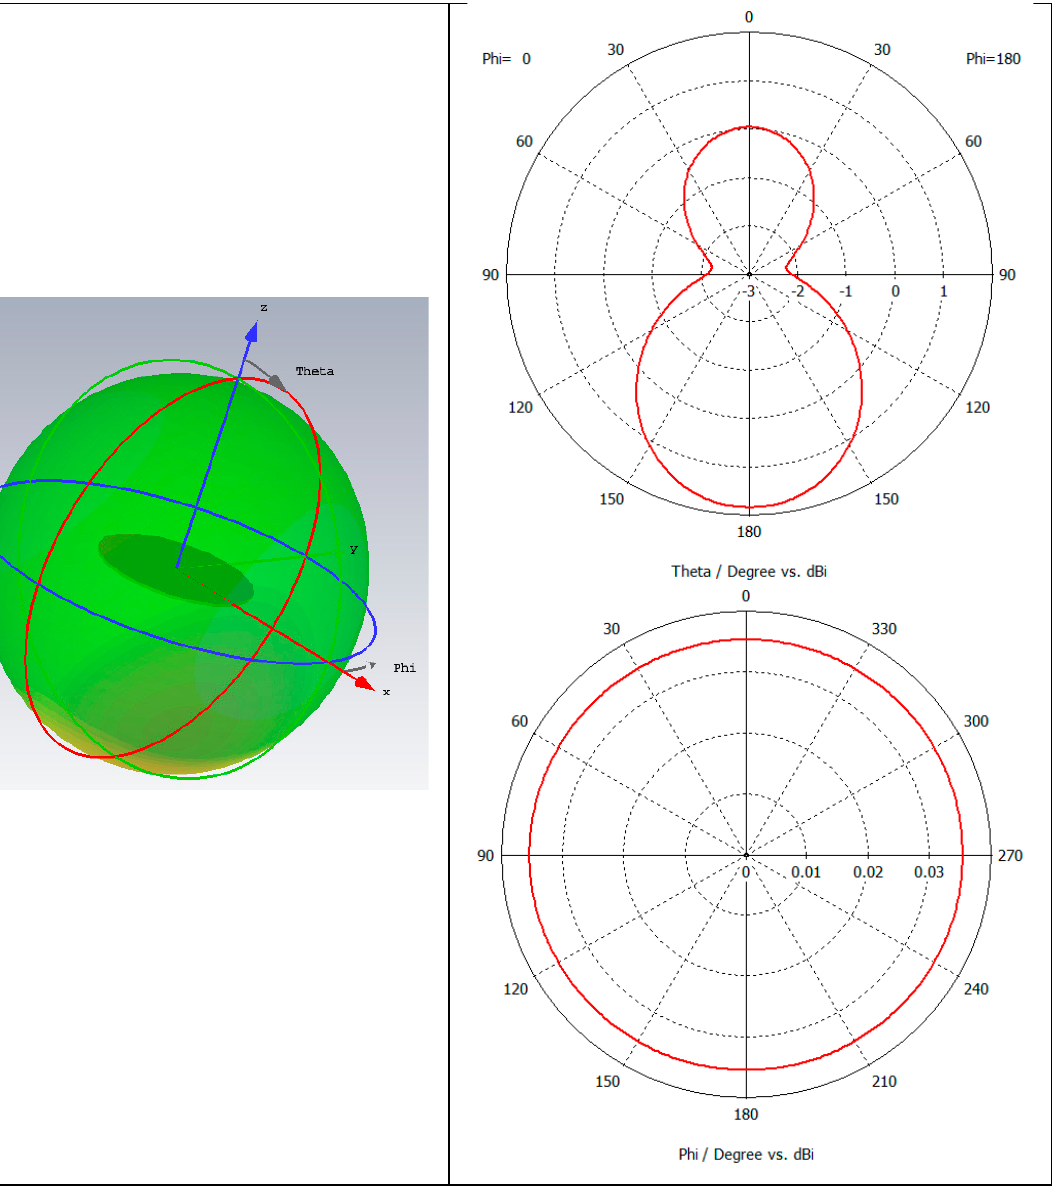
Figure 3. Radiation characteristics in the vertical and horizontal planes (2D graphs) and in space (3D graph) for a disc antenna.